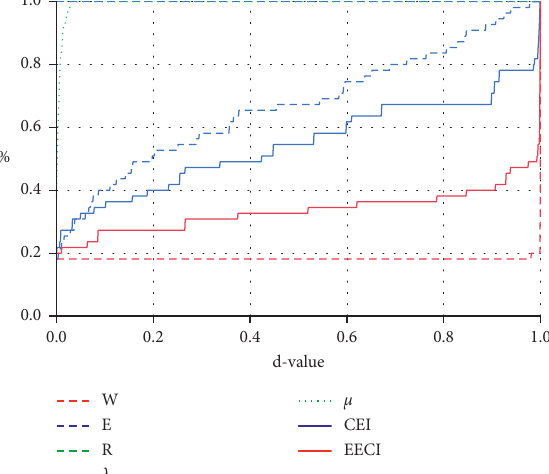
Figure 3: Random regular graph with N � 100 and d �